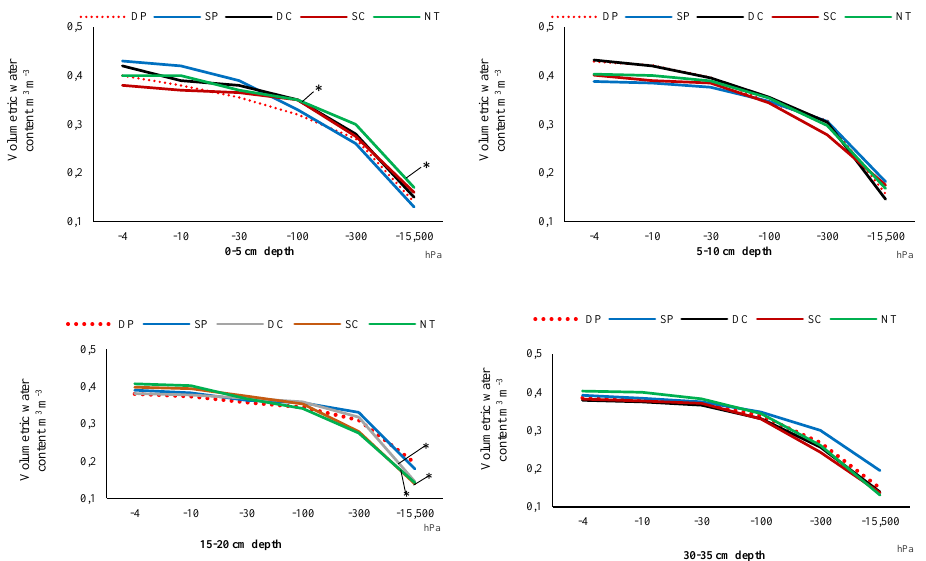
Figure 3. Effect of tillage intensity on soil water retention capacity in different soil layers, 2016. Notes: DP—deep ploughing (control treatment); SP—shallow ploughing; DC—deep cultivation; SC—shallow cultivation; NT—no tillage (direct drilling). *—significant difference at 0.01 < p ≤ 0.05. The significance of data was determined by Fisher’s least significant difference (LSD) test.